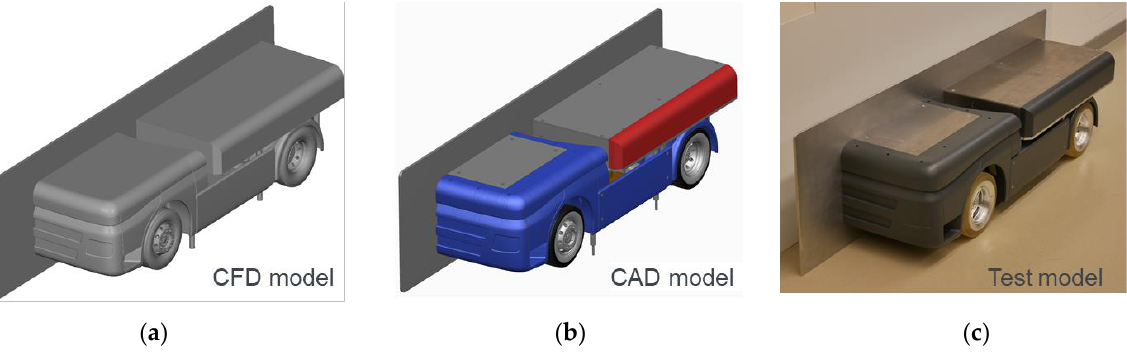
Figure 1. Quarter vehicle model of a HDV: ( a ) Geometry for CFD investigations; ( b ) CAD model for manufacturing; ( c ) Final model for testing in wind tunnel.